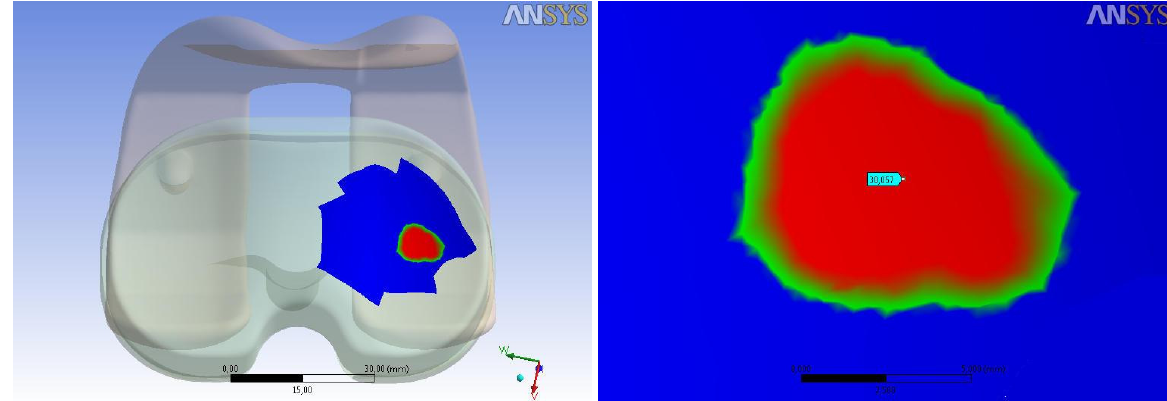
Figura 10: Configurazione a 30°: area di contatto e pressione massima. Figure 10: Configuration at 30°: contact area and maximum